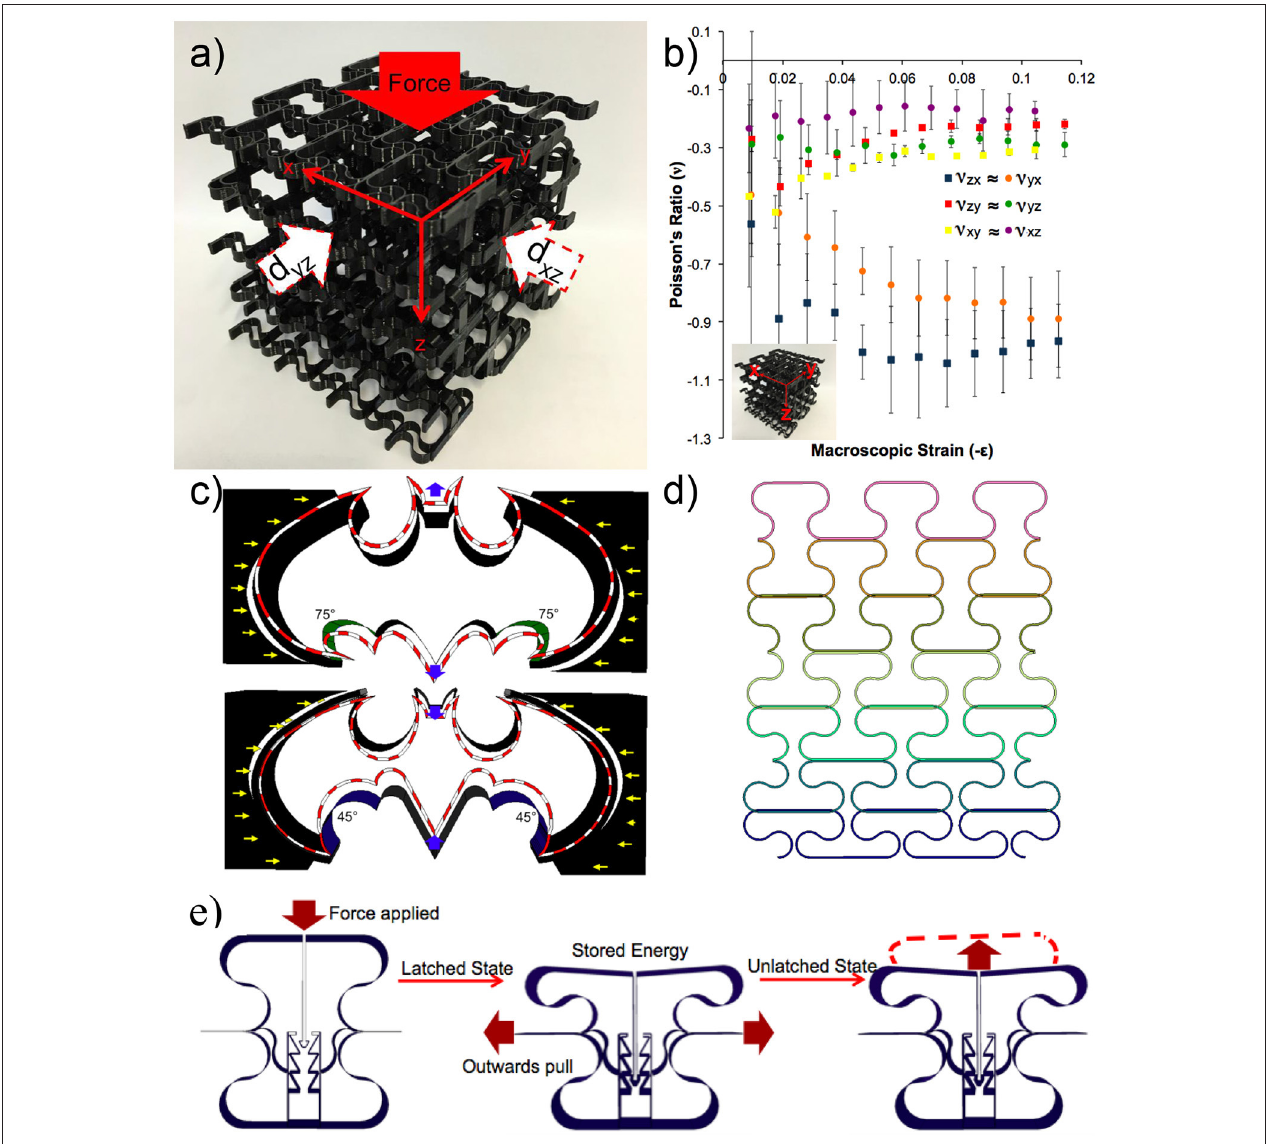
FIGURE 5 | 3D auxetic structure and Poisson’s ratio tunability and multistability. (a) 4 × 4 × 3 160-degree s-hinge 3D auxetic. Diagram shows force applied along the z-axis, and displacements along x and y. (b) Poisson’s ratio for 3D s-hinged auxetic as a function of macroscopic strain in all directions are negative. Legend notation: the first letter is the transverse and the second is the axial axis along which the structure is compressed where the Poisson’s ratio ν yz = –d yz /d Force . (c) Poisson’s ratio can be tailored by changing only the arc angle of the hinge, as illustrated by the arcs of the body and the tail connecting to the wings in the Batman logo. The top (original) Batman logo is not auxetic, but it becomes so when you change from the green arc (75 degree arc angle) to the blue arc (45 degree arc angle), the bottom dashed red line. (d) S-hinge can be developed into a gradient auxetic with changing arc angles and thus continuously tunable Poisson’s ratios. (e) The multistable auxetic unit cell in relaxed/expanded state can be pushed down to yield a latched state that stores elastic energy in the absence of an external force. The latched state can be released by pulling open the transverse ledges, making use of the anisotropic auxetic properties of the